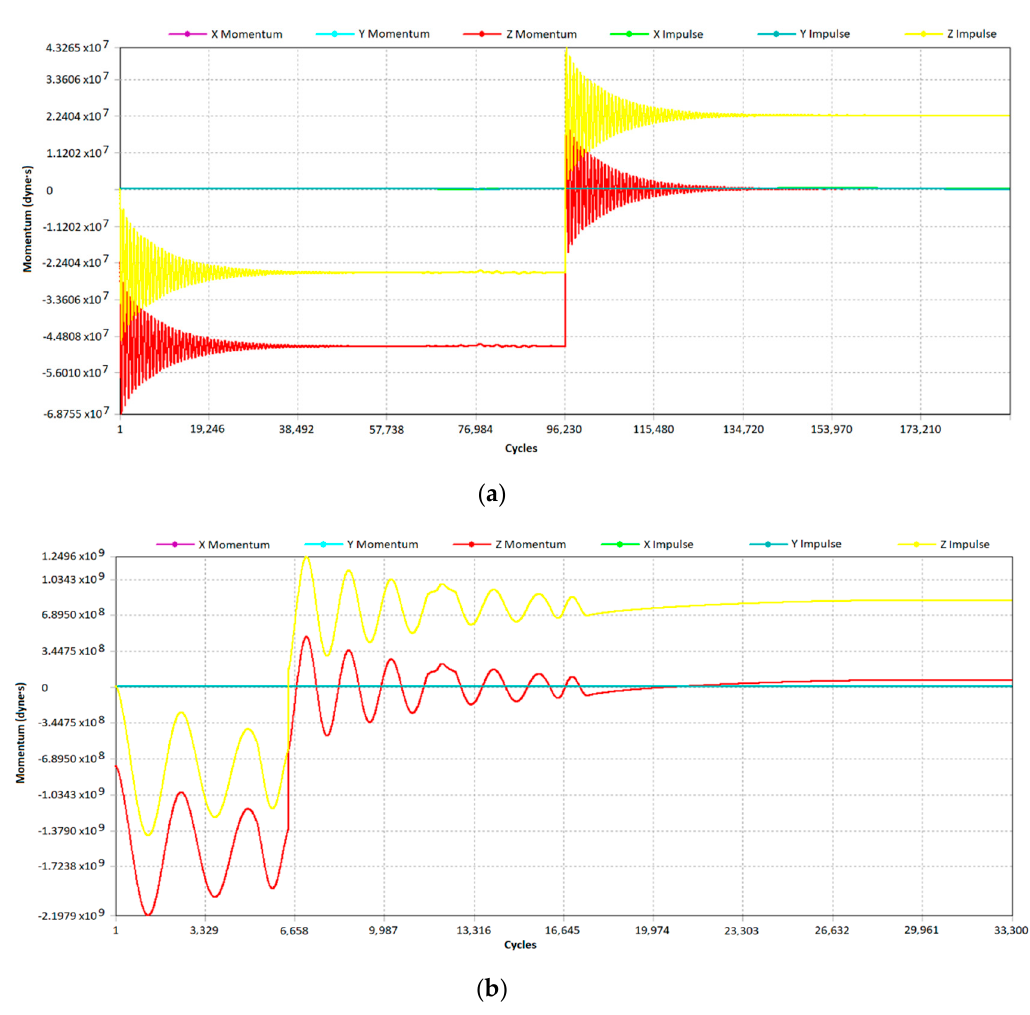
Figure 15. Graphs produced from the analysis of the motion of a tulip contact, presenting a summary of moments: ( a ) Normal operation and ( b ) contact destruction.